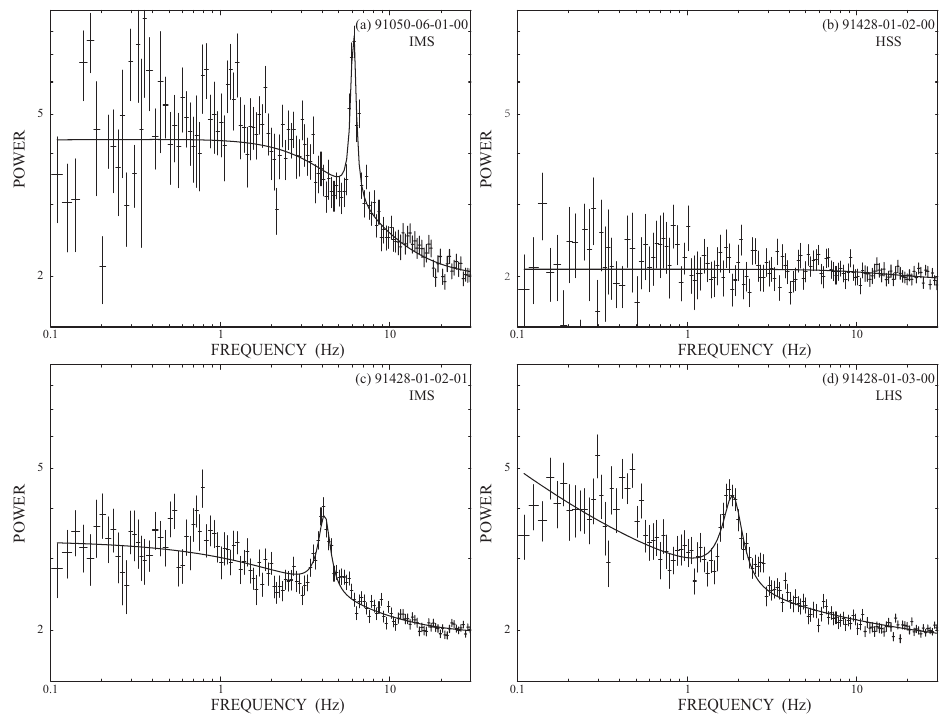
Figure 4. The power density spectra of H 1743-322 among LHS, HSS and LHS.